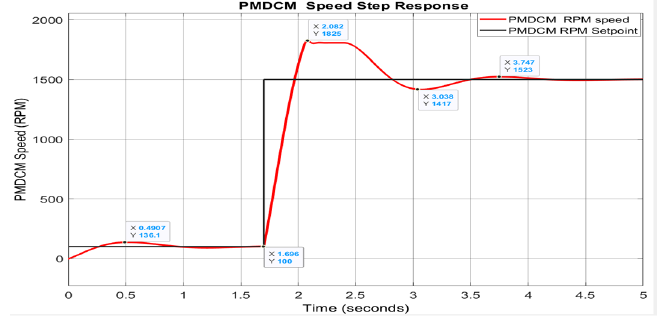
Figure 32. PMDCM RPM speed step response.